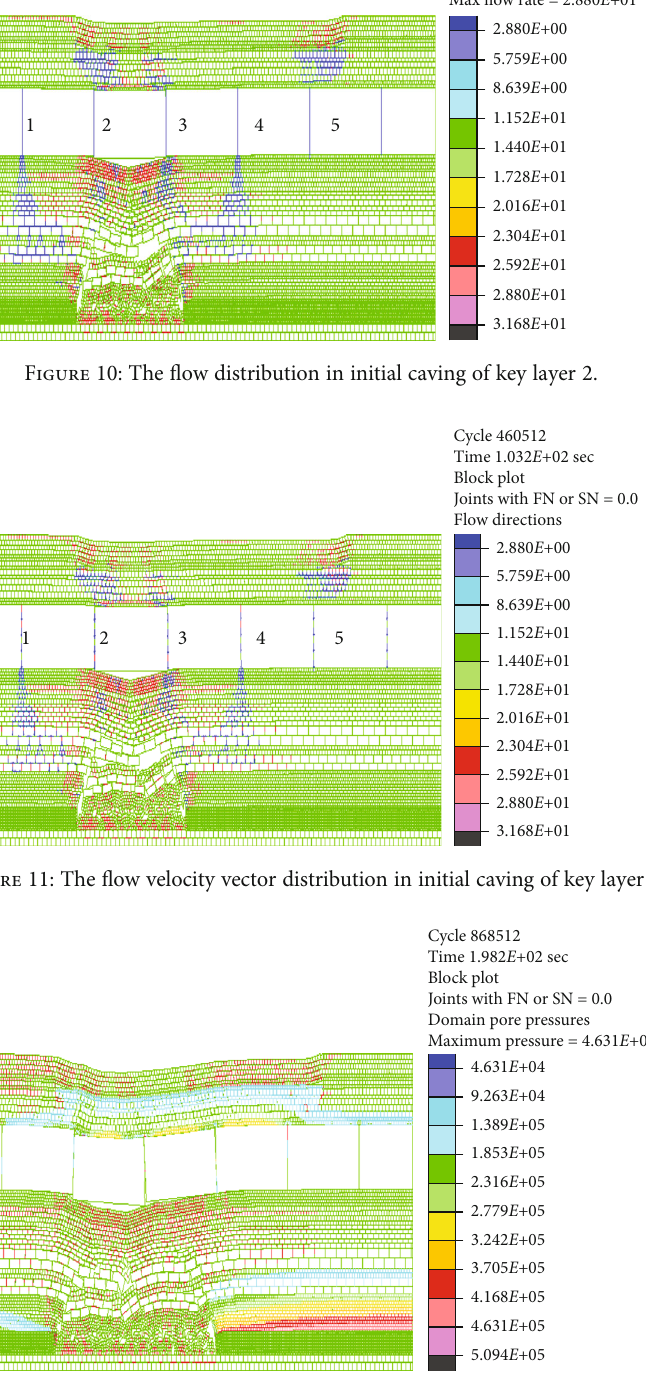
Figure 12. The fl ow distribution in the initial caving of key